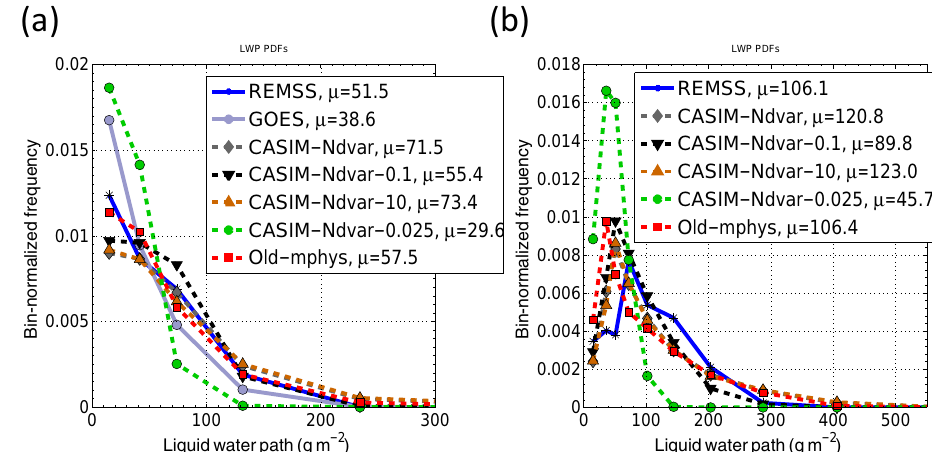
Figure 8. PDFs of LWP for daytime (left) and nighttime (right) time periods for the model and for satellite observations. “REMSS” refers to the several available REMSS microwave instruments, each of which provides a snapshot LWP field. For the daytime, the times surrounding the minima in the LWP diurnal cycle (see Fig. 4) are used (10:00–18:00LST on both 12 and 13 November; overall four REMSS snapshots). For the nighttime, only the REMSS satellites are shown; times are chosen surrounding the maxima of the LWP cycle, but the surrounding period is reduced compared to the daytime in order to match the limited available REMSS times as closely as possible (03:00–09:00LST on 12 November, 20:00LST on 12 November to 10:00LST on 13 November, 18:30–20:00LST on 13 November; contains nine REMSS snapshots). The model and GOES-10 data have been coarse-grained to the AMSR-E resolution of 0.25 ◦